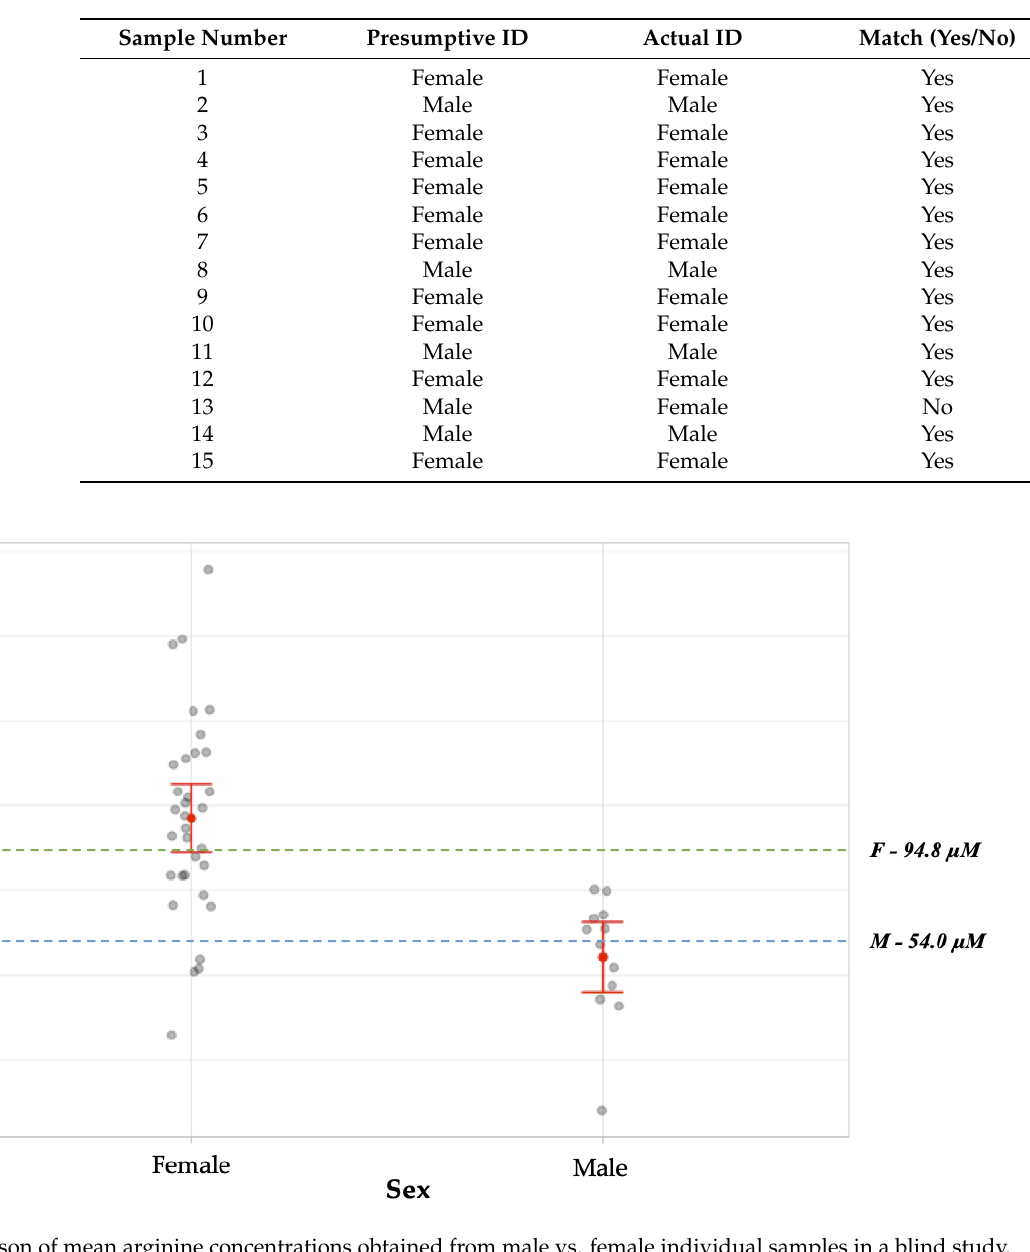
Table 1. Summary of results obtained from the blind study. The biological sexes of all participants were correctly determined except for one case.